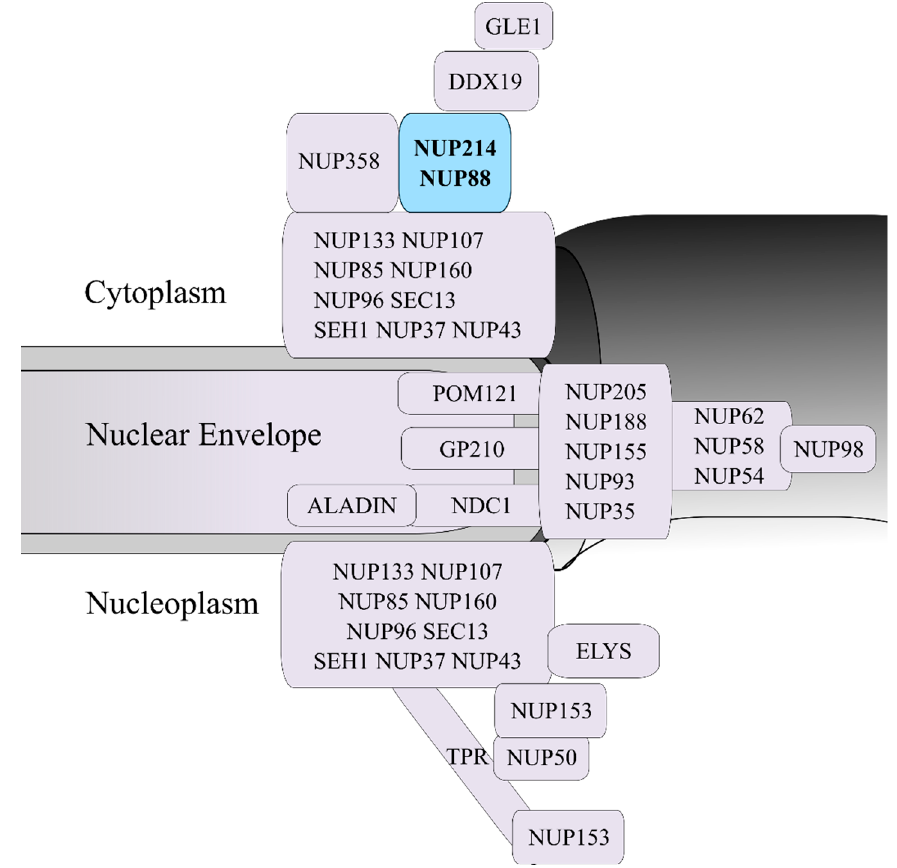
Figure 1. Schematic representation of the human nuclear pore complex (NPC) and the localization of nucleoporins within the NPC 3D structure. The NUP214-NUP88 complex, which is localized in the cytoplasmic side of the NPC, is highlighted in blue.